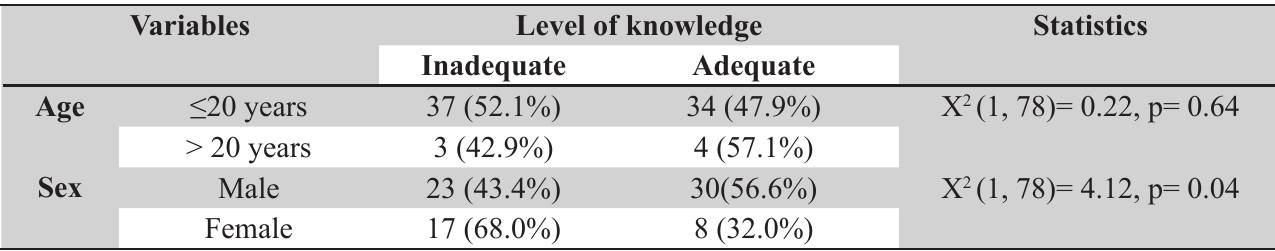
Table 2. Association between level of knowledge and demographic variables (N=78).